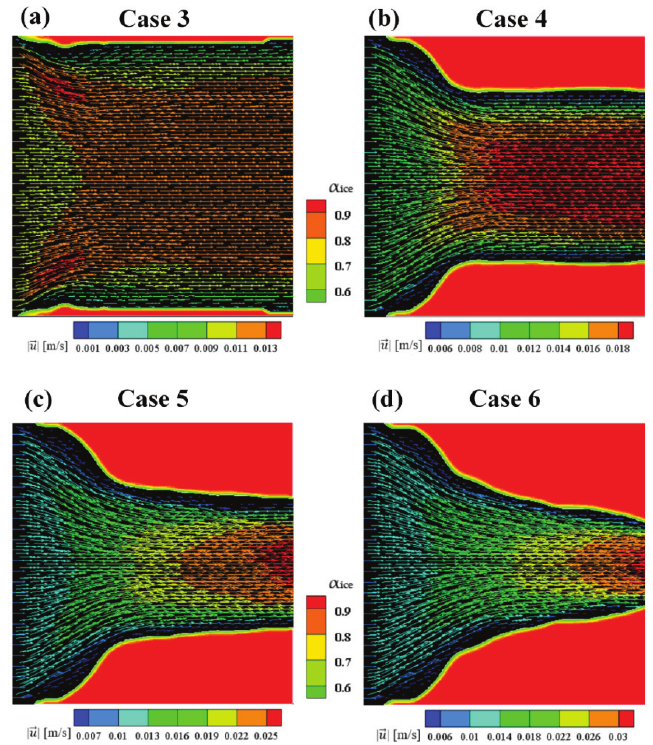
− 1 ) of water and n-hexanol at t = 0.4 s under di ff erent Figure 14. Vector graph of fluid velocity (ms (cid:442) 1 ) of water and n-hexanol at t = 0.4 s under different Figure 14. Vector graph of fluid velocity (ms